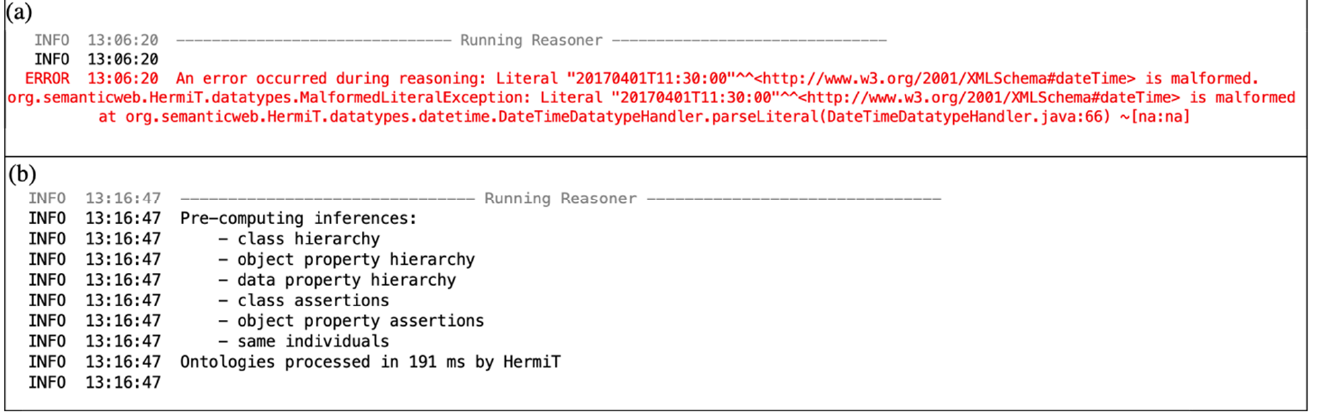
Figure 12. ( a ) Initial reasoning result with an error. ( b ) Subsequent reasoning result.